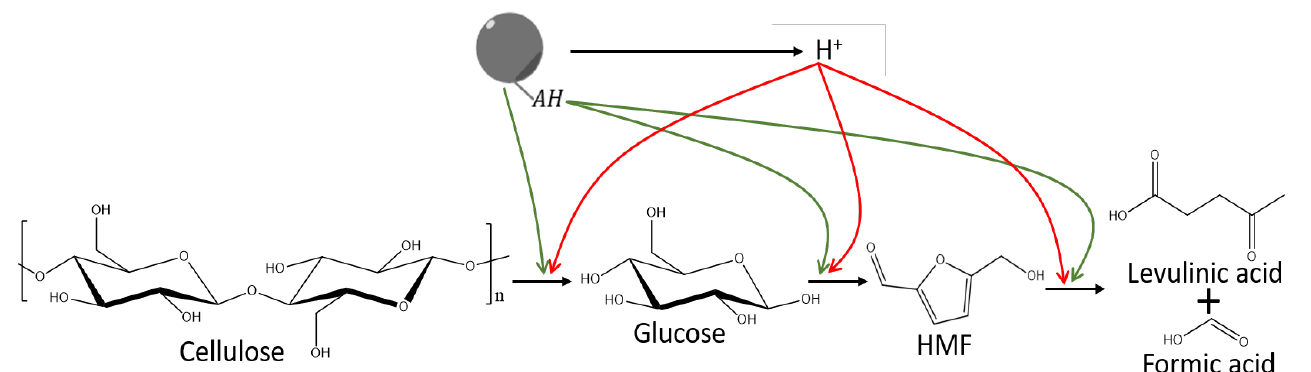
Scheme 2. Cellulose hydrolysis, product decomposition, and catalyst leaching reaction pathways. The red and green arrows indicate homogeneous and heterogeneous catalyzed reactions, respectively.